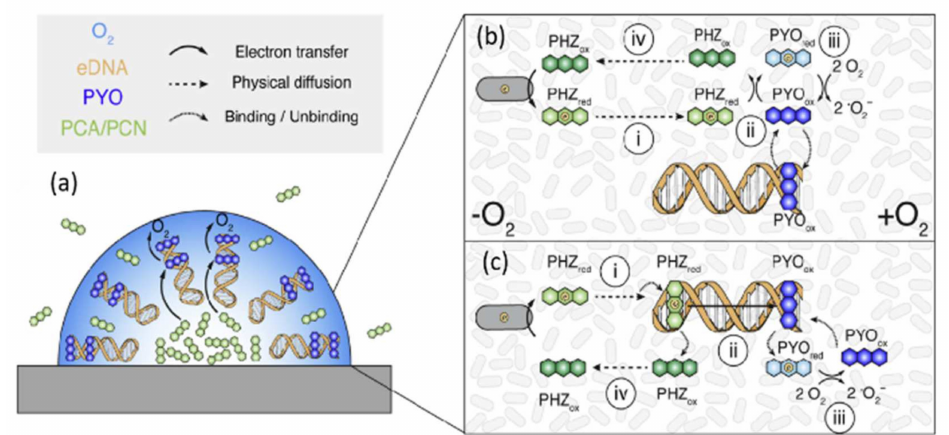
Figure 4. Schematic diagram of eDNA and the electron shuttle compound phenazine bind in biofilm. ( a ) Phenazine binds eDNA to transfer electrons to oxygen in biofilms; ( b , c ) two mechanisms of eDNA-mediated phenoazine electron transport [84]. Reproduced with permission from